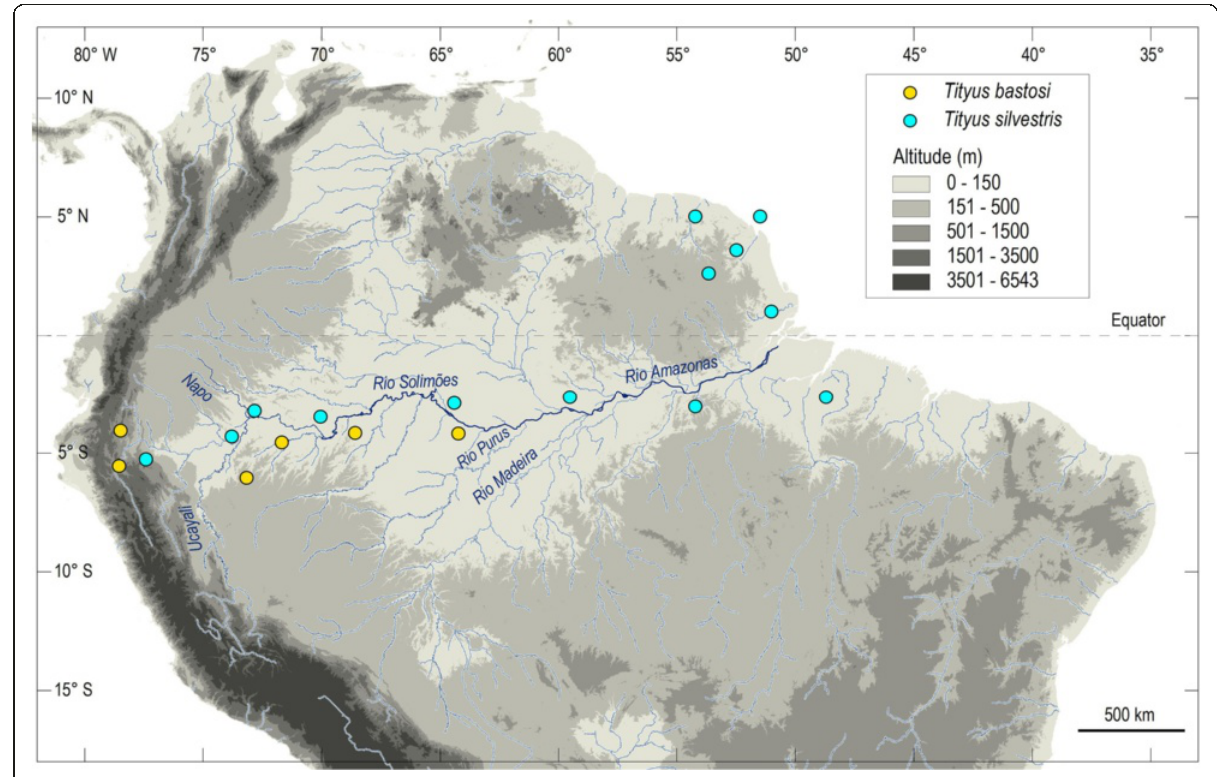
Fig. 26 Map of northern South America – Amazonian and Guayana regions – showing the known distribution of two polymorphic species of